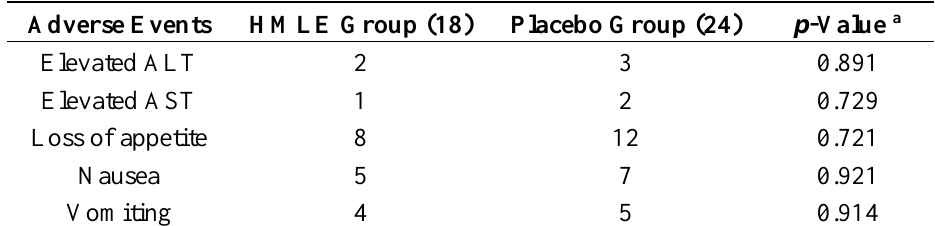
Table 4. Adverse events reported during the study period.